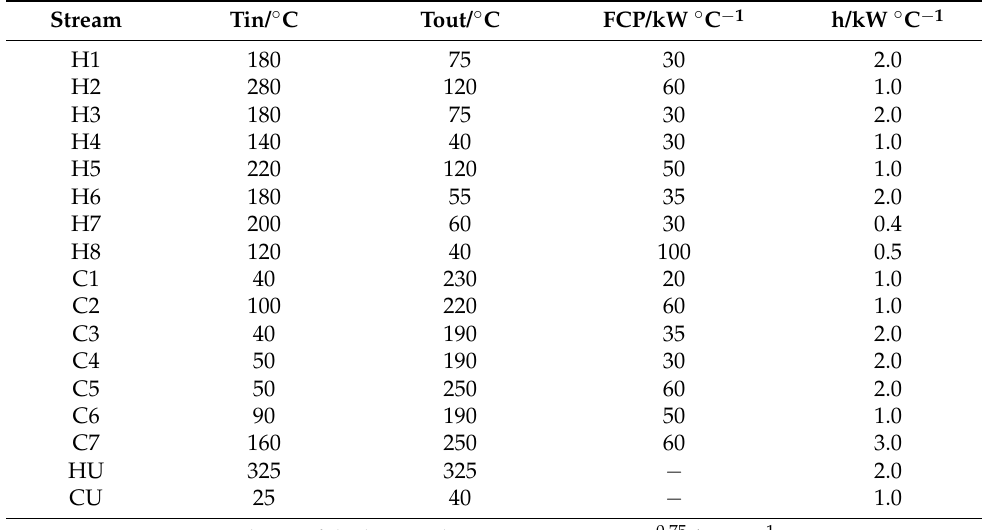
Table 2. Flow parameters of Case 2.